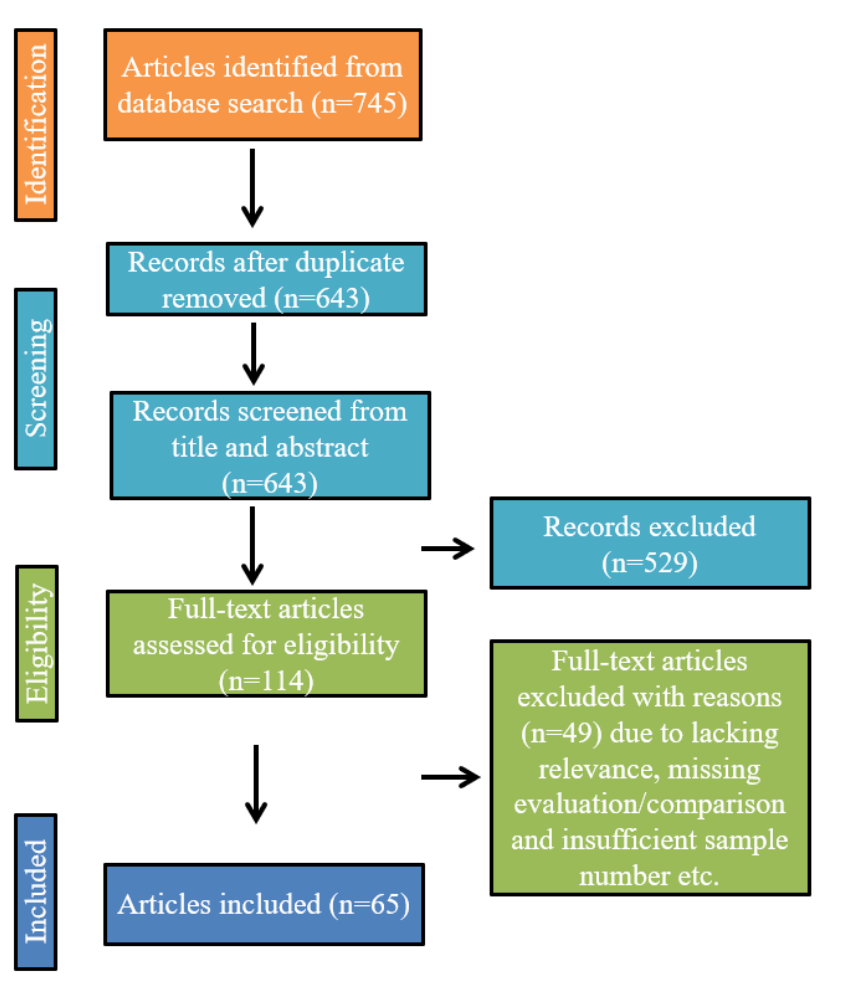
Figure 1. Flow diagram of the article selection process for literature review.